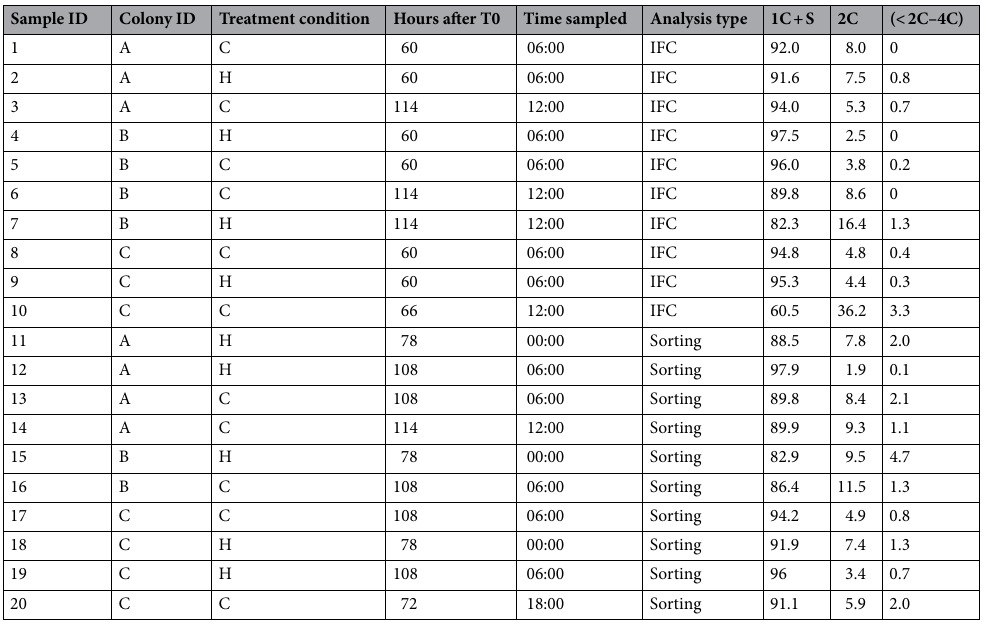
Table 1. Details of the Symbiodiniaceae samples analyzed in this study and the % of DNA content classifications made from each sample. All samples analyzed (Sample ID) originated from three colonies of Pocillopora species complex (Colony ID) collected from the north shore forereef in Mo’orea, French Polynesia during the dry season (July 2019). Colonies A and B were Pocillopora meandrina : Colony C was not identifiable to species. All three colonies contained only Cladocopium latusorum symbionts. Treatment Condition: C: Control, ambient temperature, ~ 27 °C; H: Heat stress, ~ 30 °C. ‘Hours after T0’ indicates the cumulative hours that corals had been exposed to the treatment condition at the time of sampling. Analysis Type: IFC = Image Flow Cytometry; Sorting = Sorting Flow Cytometry. A minimum of 10,000 cell nuclei were analyzed for DNA content in each sample.